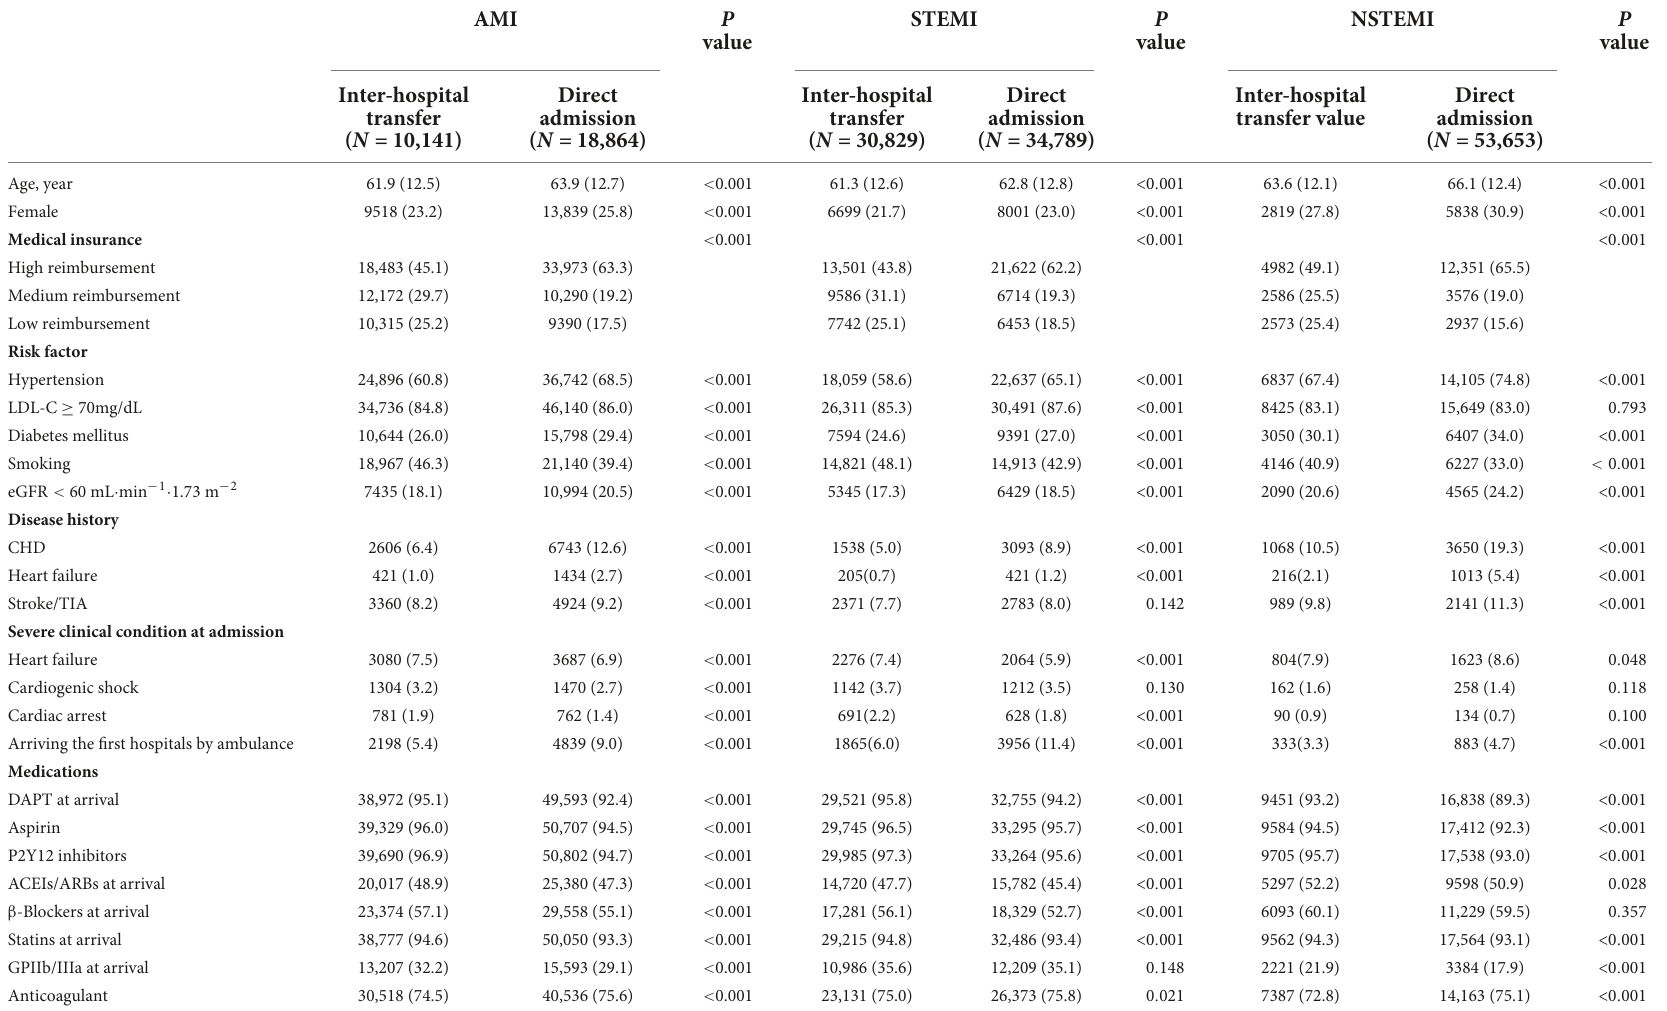
TABLE 1 Characteristics of patients with AMI transferred from another hospital or directly